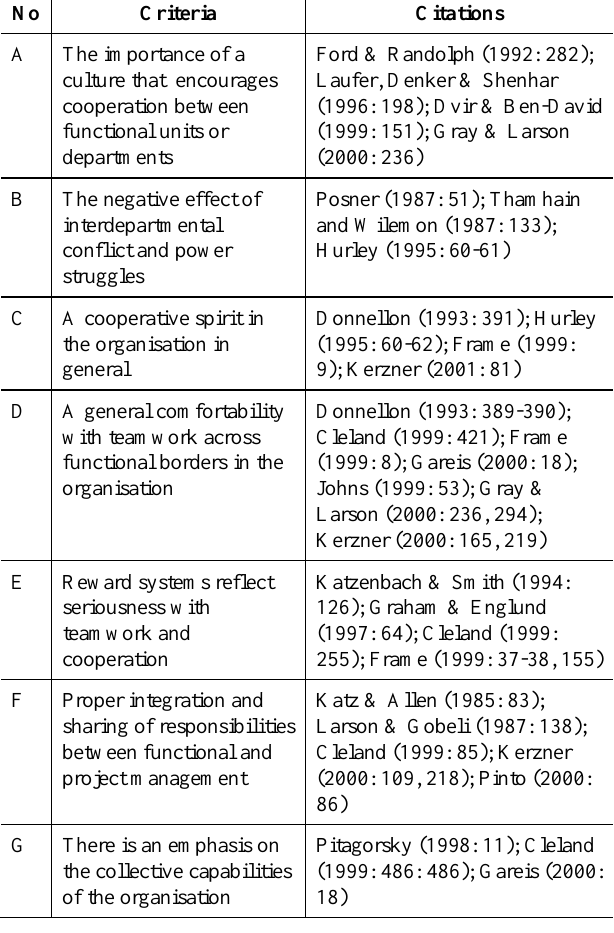
Table 3: Organisational criteria suggesting an integrated organisation Criteria